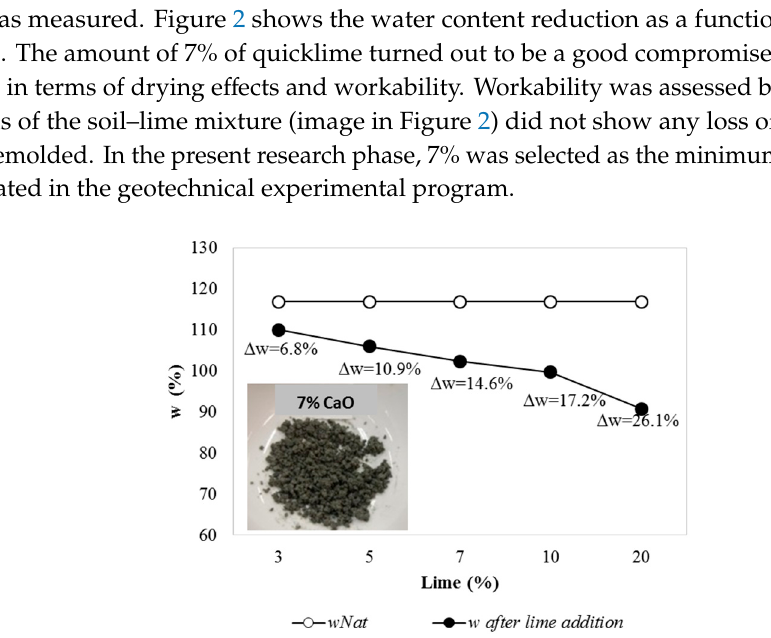
Figure 2. Water content reduction as a function of lime amount. ( Δ w = natural soil water content— water content after lime addition). The image shows the features of the soil after the addition of 7% quicklime.